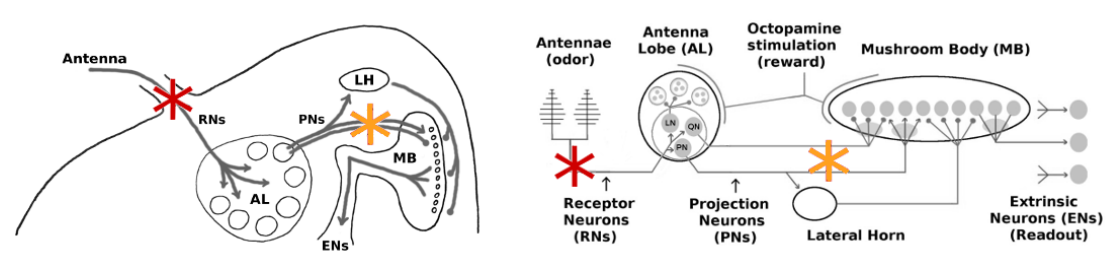
Figure 2. Location of injuries in experiments. Damage to Antennae affects the Receptor Neurons (RNs) (red stars) and reduces the overall input to the AL. Damage to the AL → MB channel (orange stars) weakens the signals passed by both excitatory projection neurons (PNs) and inhibitory projection neurons